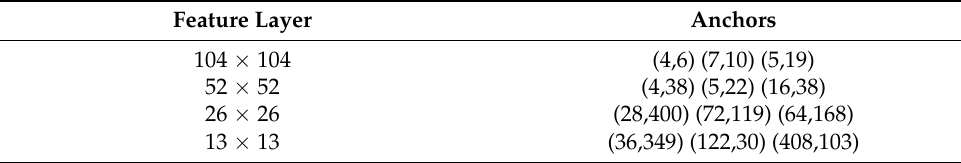
Table 1. Anchors for each feature